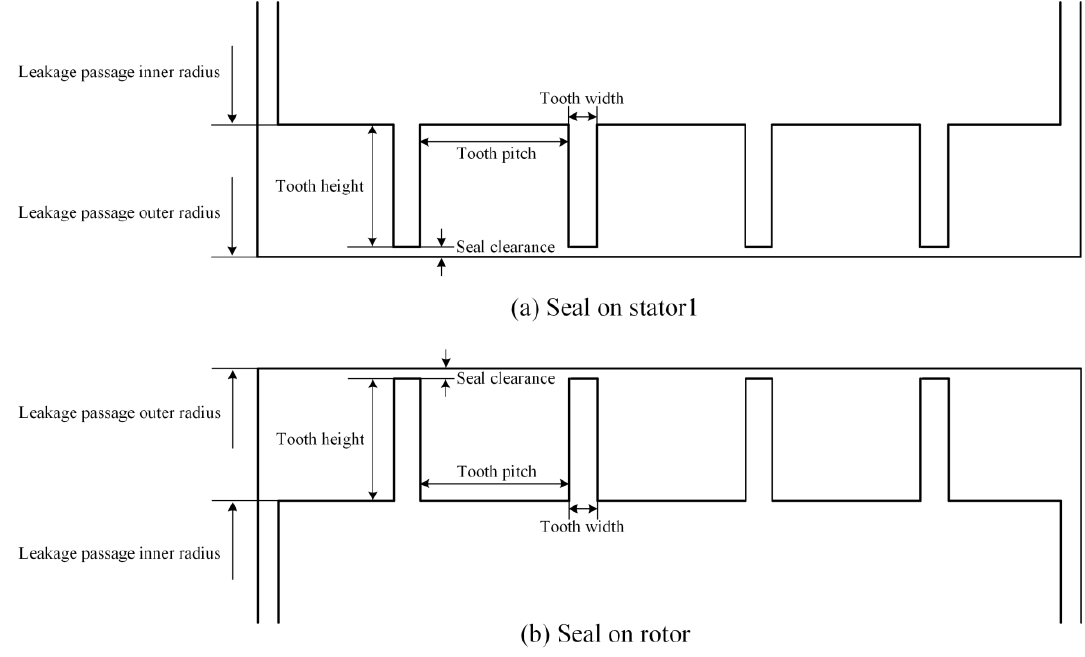
Figure 2. Schematic diagram of the seal structures. Table 2. Geometry parameters of seal structures.